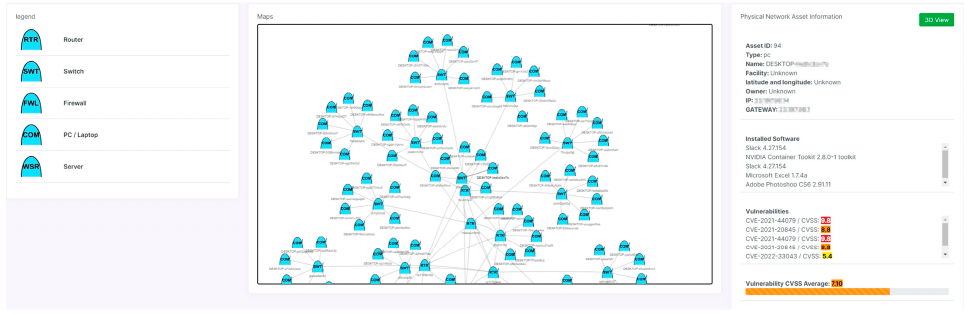
Figure 10. Visualization ④ : Visualization of Internal Network of Facilities.